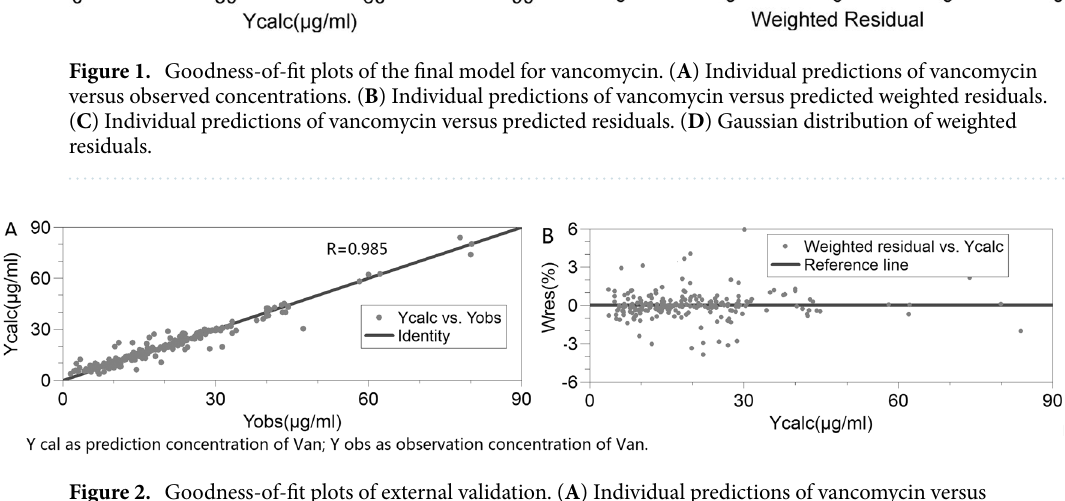
Figure 2. Goodness-of-fit plots of external validation. ( A ) Individual predictions of vancomycin versus observed concentrations. ( B ) Individual predictions of vancomycin versus predicted weighted residuals.